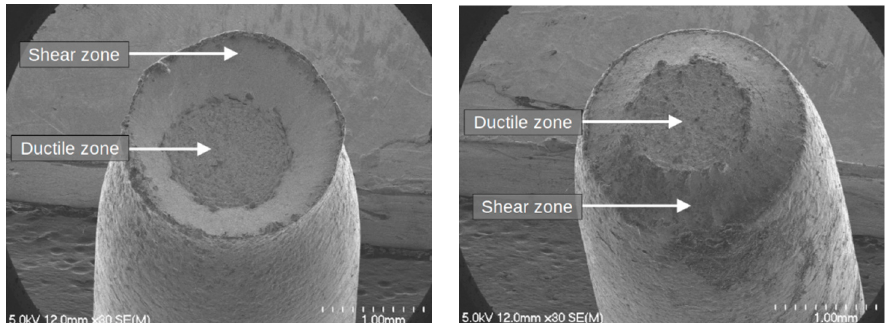
Figure 16. Tensile test fracture surface of a low-corroded steel wire (252 days, wire from greased cable, UTS = 10.89 kN, total deformation = 6.10%).